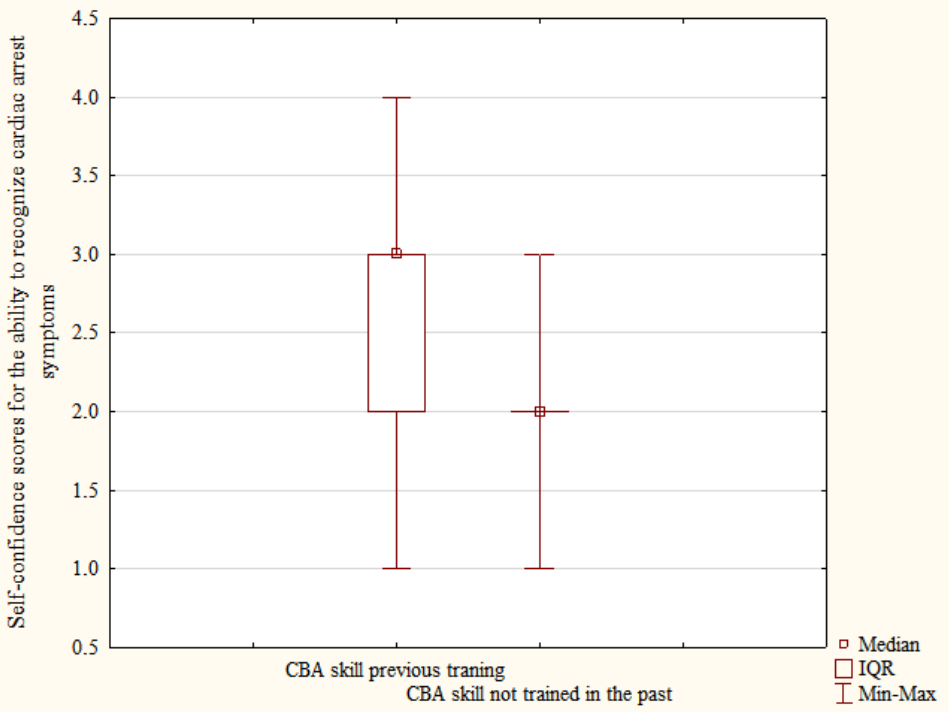
Figure 2. Self-confidence scores-recognition of cardiac arrest symptoms between study participants who previously trained their skills of assessing consciousness and the presence of normal breathing (CBA skill) and those who did not pre-test data. Table 2. Self-confidence scores for the ability to perform proper chest compressions depending on previous